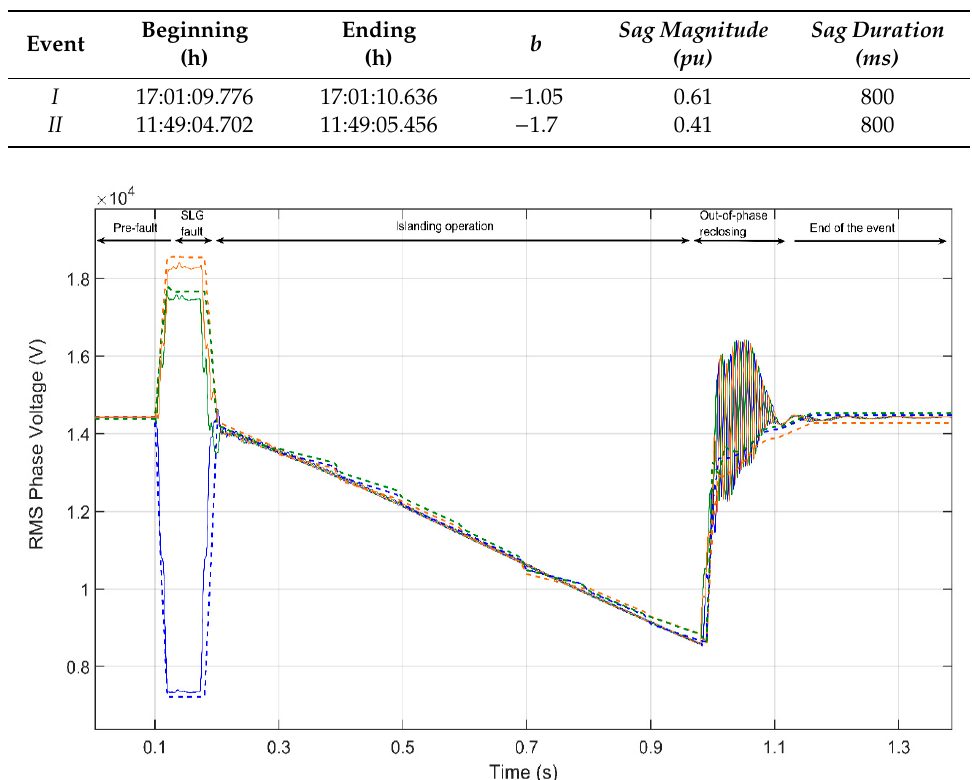
Figure 12. Event I comparison. Solid (simulation) / dashed (measurements): orange (Phase A), blue (Phase B) and green (Phase C).